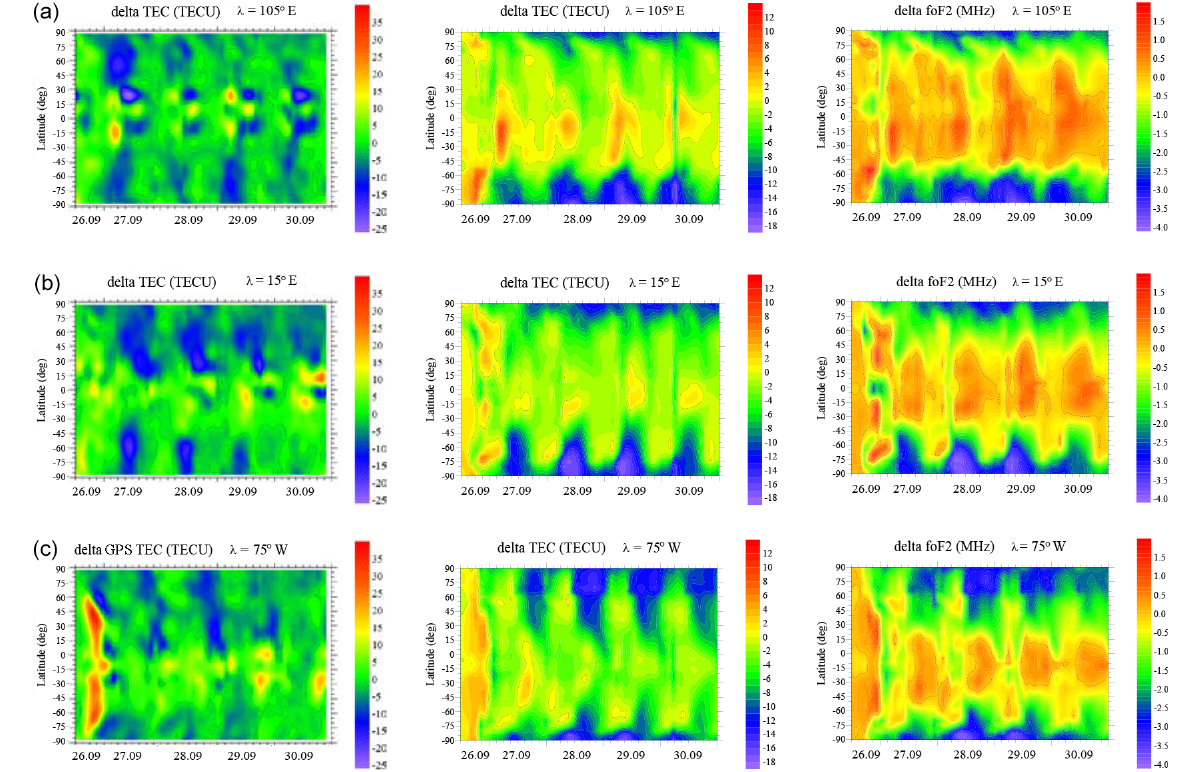
Figure 4. Behavior of the GPS TEC disturbances, and the GSM TIP model-derived disturbances in TEC and fo F2 during geomagnetic storms on 26–30 September 2011 at the longitude of 105 ◦ E (a) , 15 ◦ E (b) , and 75 ◦ W (c)